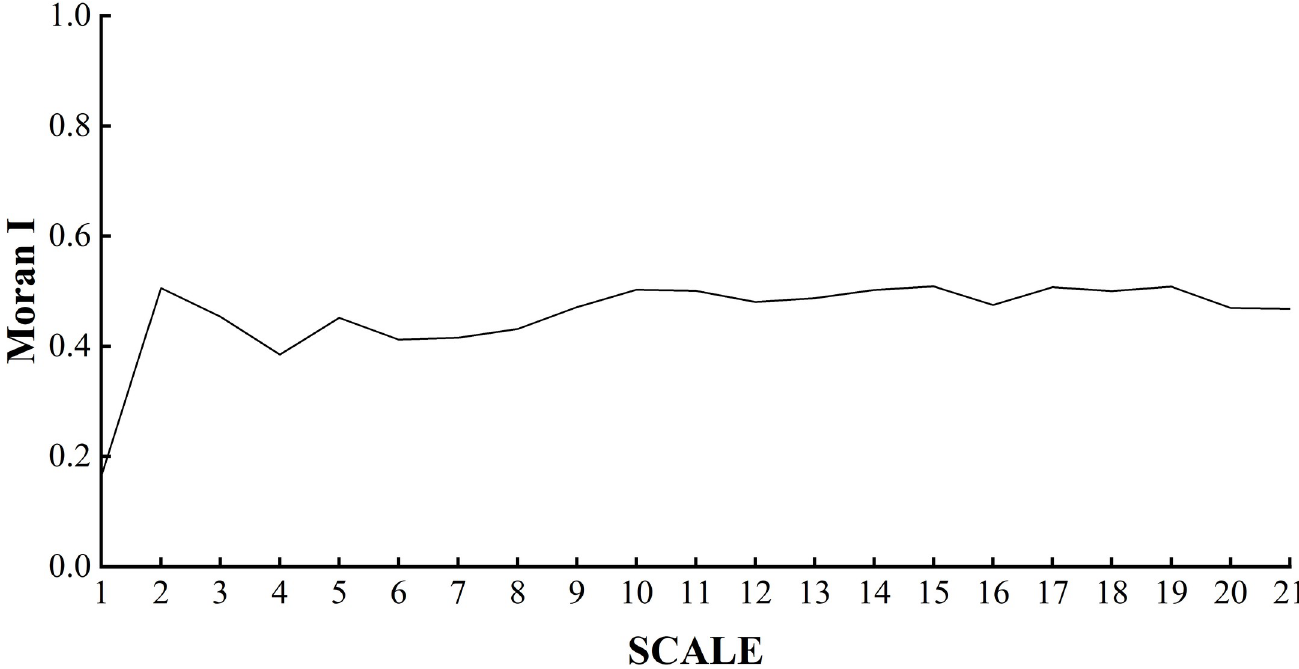
Fig 8. Scale relationship plot of the Moran index of architectural landscape pattern.